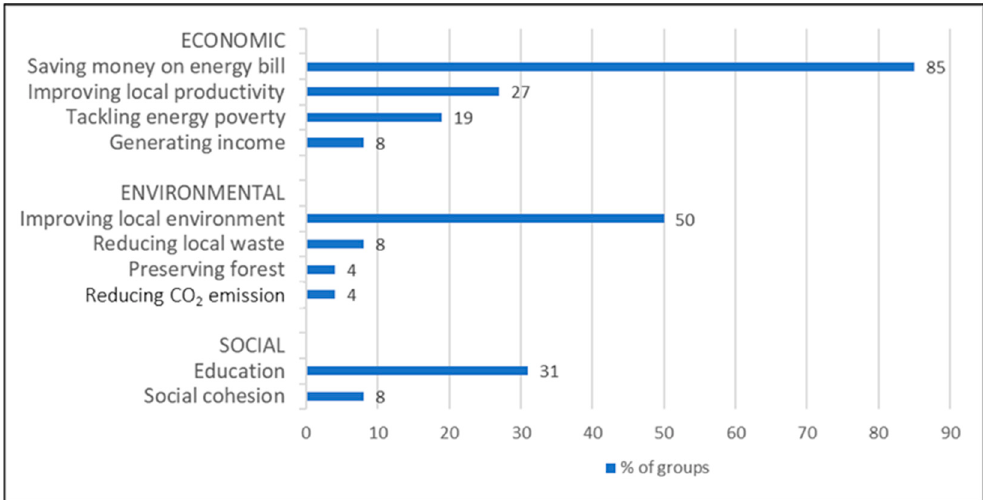
Figure 3. Objectives of Thai CRE groups.